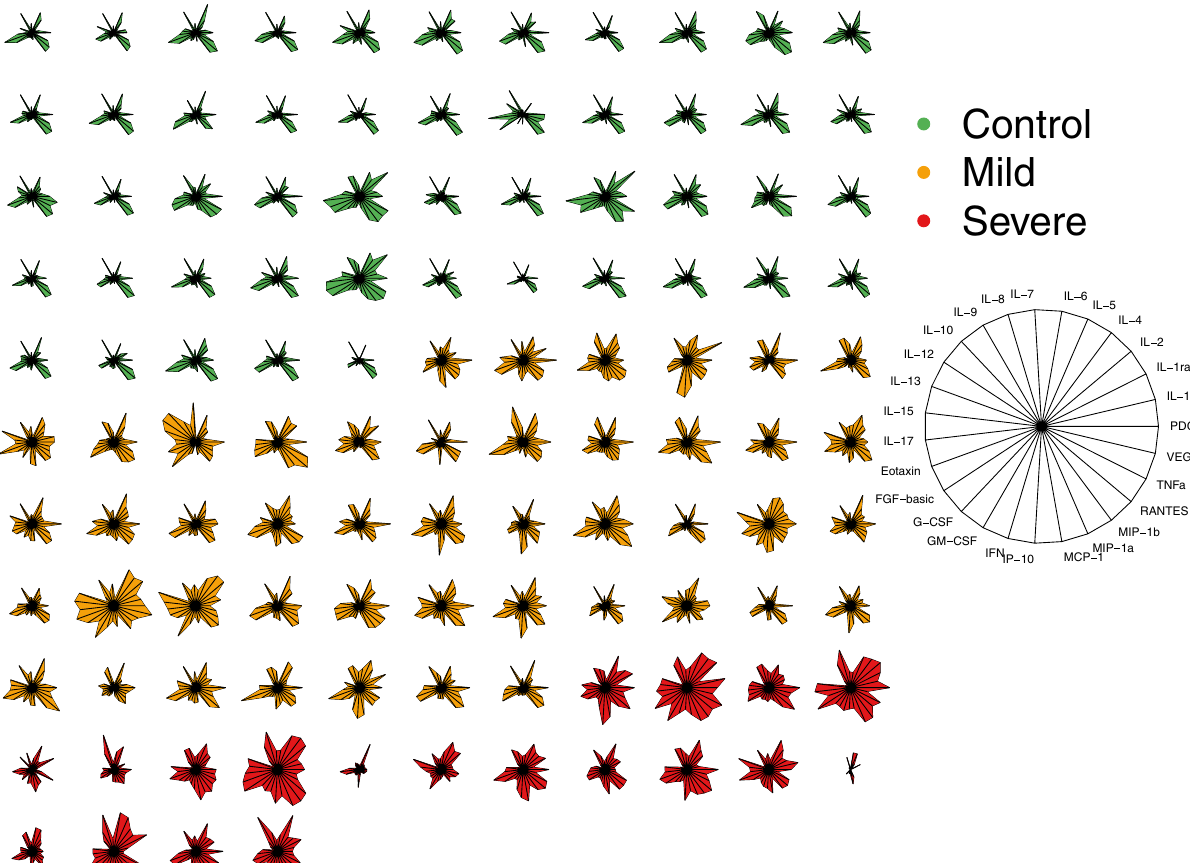
Figure 2. Cytokine-based pattern of COVID-19 patients. Star plot obtained by multivariate data analysis of whole cytokinome of every subject consists of a sequence of equi-angular spokes (radii), with each spoke representing one cytokine as indicated in figure legend on the right. Data length of a spoke is proportional to the magnitude of the variable for the data point relative to the maximum magnitude of the variable across all data points. A line is drawn connecting the data values for each